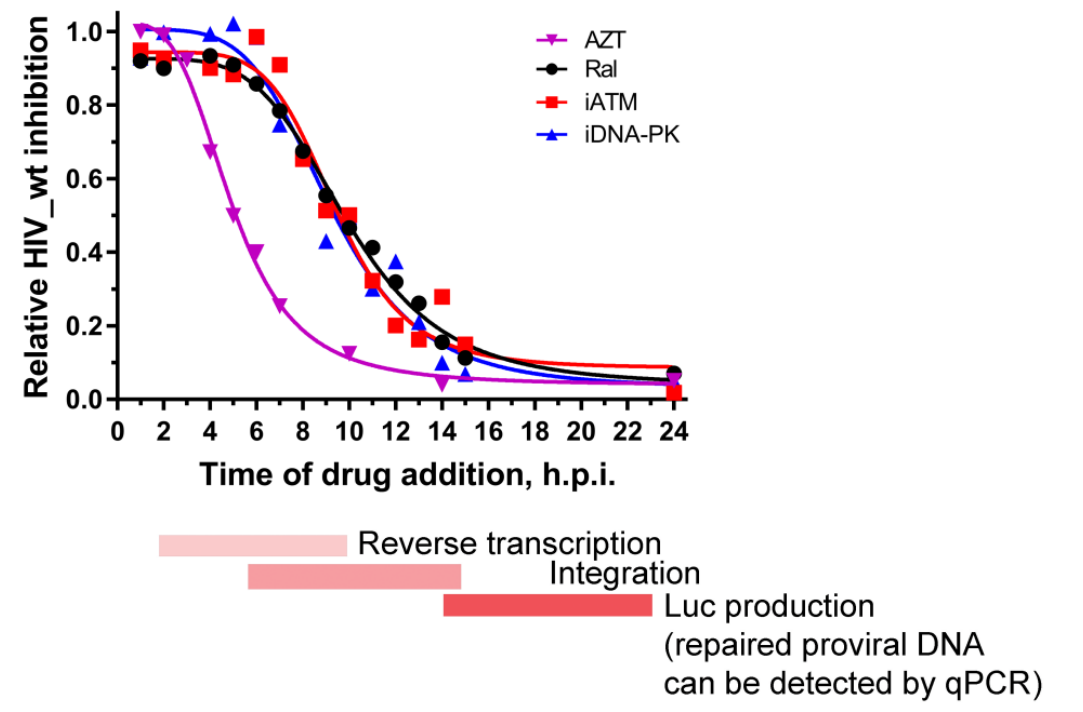
Figure 3. Dependence of the activity of inhibitors on the time of their addition to HIV_wt transduced cells. 293T cells were transduced by HIV_wt for 1 h, then the excess of the vector was removed; inhibitors (AZT, Ral, iATM or iDNA-PK) were added to the cells 1–24 h.p.i. Luciferase expression was tested 48 h.p.i. The mean values of three independent experiments are presented.